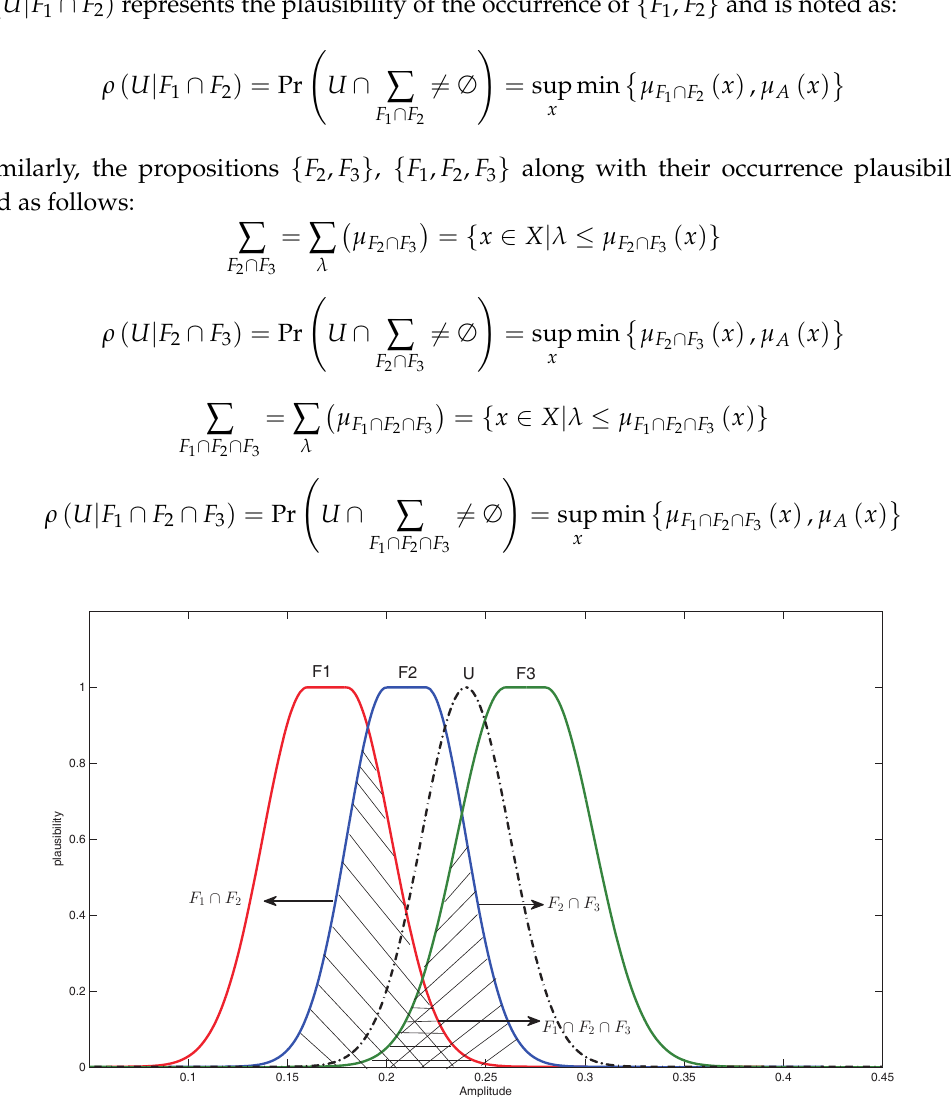
Figure 5. The membership functions of the test simple mode and three typical